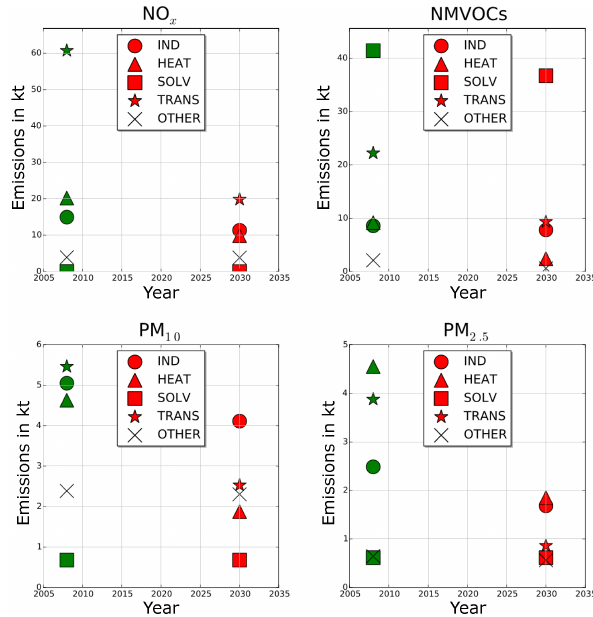
Figure 2. Annual present-time emissions of NO x , NMVOCs, PM 10 and PM 2 . 5 in IdF and their projections for 2030. IND corresponds to industrial emissions (SNAP1, 3 and 4), HEAT to heating activities (SNAP2), SOLV to solvents use (SNAP6), TRANS to road and non- road transport (SNAP7 and 8) and OTHER represent the remaining source sectors (SNAP5, 9 and